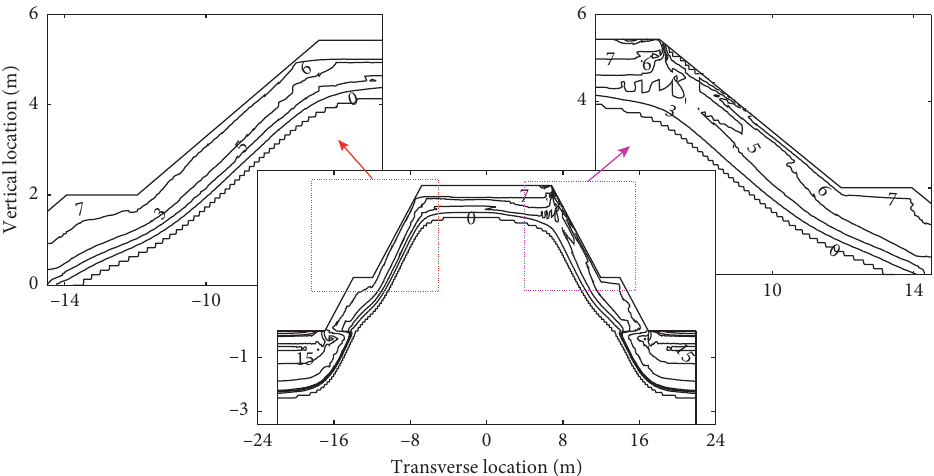
Figure 6: Distribution of the mass content of ice at the roadbed section on March 10, 2014